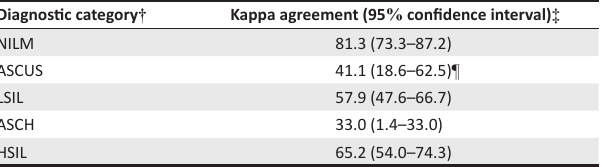
TABLE 2: Level of agreement between conventional cytology and Cellslide® for each diagnostic category amongst samples from HIV-positive women ( n = 348) in Johannesburg, South Africa (November 2009 to August 2011).